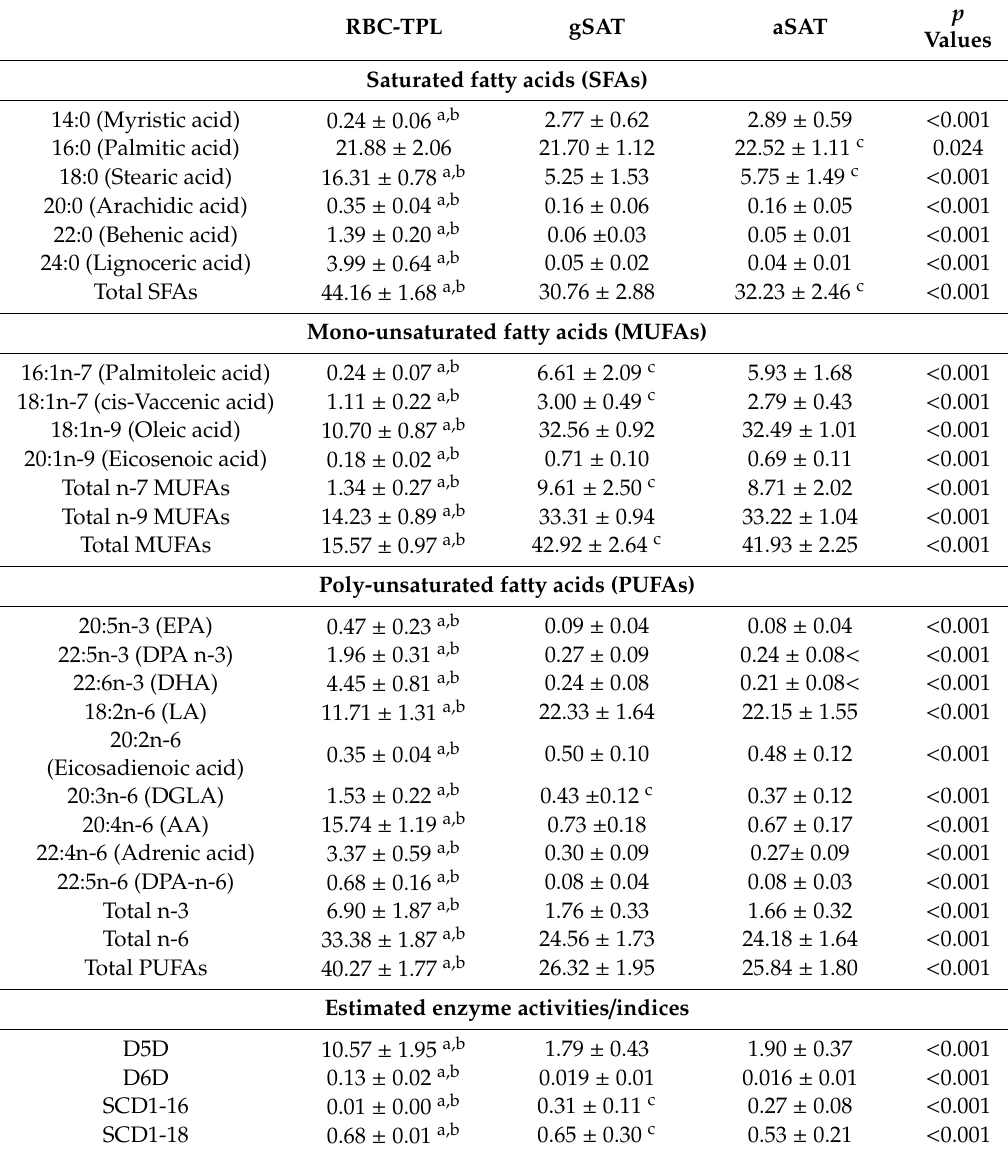
Table 3. Comparison of fatty acid composition (percentage) between red blood cell total phospholipids, gluteal and abdominal subcutaneous adipose tissue